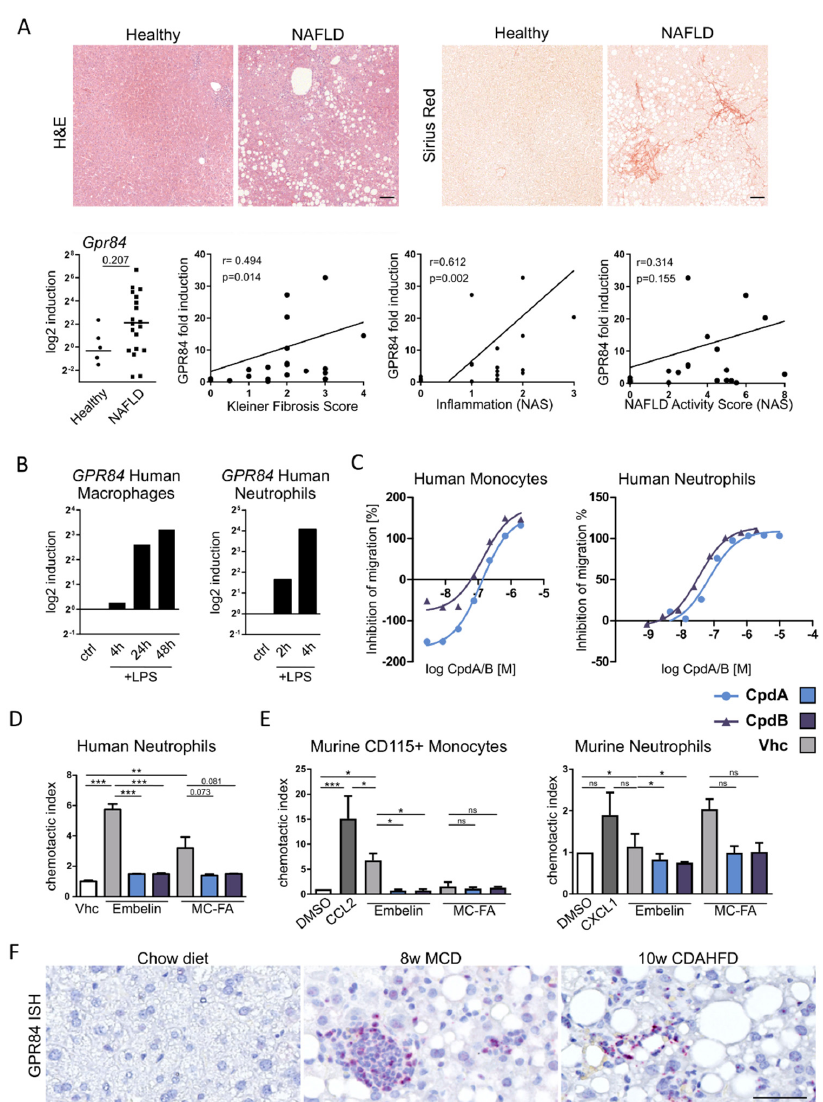
Figure 1. Inflammatory induction of GPR84 in mice and men promotes myeloid cell chemotaxis in vitro. ( A ) Liver biopsies of healthy control ( n = 5) and NAFLD patients ( n = 19) were analyzed. Representative H&E and Sirius Red stainings of para ffi n-embedded liver sections revealed steatosis and inflammation in NAFLD patients. GPR84 gene expression tended to be elevated in livers of NAFLD patients compared to healthy controls and was significantly correlated with the histological degree of inflammation and fibrosis. ( B ) GPR84 expression of primary human macrophages and neutrophils upon LPS stimulation in vitro. Representative data from one human donor. ( C ) Dose-dependent inhibition with two GPR84 antagonists on embelin-induced migration of human primary monocytes and neutrophils. ( D ) Migration of human neutrophils was induced by embelin (GPR84 agonist) or medium-chain fatty acids (MCFA) and was e ff ectively inhibited by the two GPR84 antagonists. ( E ) Migration of CD115 + monocytes and neutrophils from mouse bone marrow towards embelin or MCFAs. ( F ) GPR84 mRNA in situ hybdridization in representative liver sections of experimental dietary mouse models. Scale bar, 100 µ m. Data are presented as mean ± SD. * p < 0.05, ** p < 0.01, *** p < 0.001 (unpaired Student’s t -test in A, ANOVA in D + E, Spearman’s r, and p -values of linear correlation analysis in A). Abbreviations: CCL2, C-C motif chemokine 2; CpdA / B, compound A / B; LPS, lipopolysaccharide; Vhc, vehicle; MCD diet, methionine choline deficient diet; and CDAHFD, choline-deficient, L-amino acid-defined, high-fat